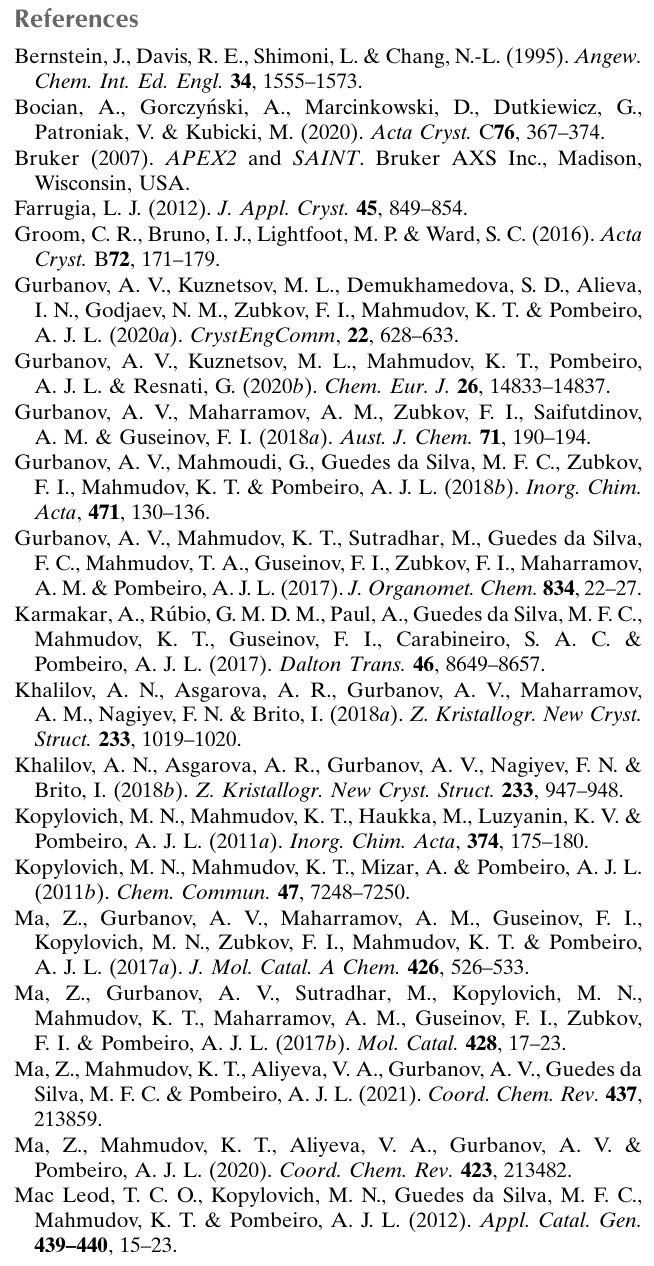
Data collection